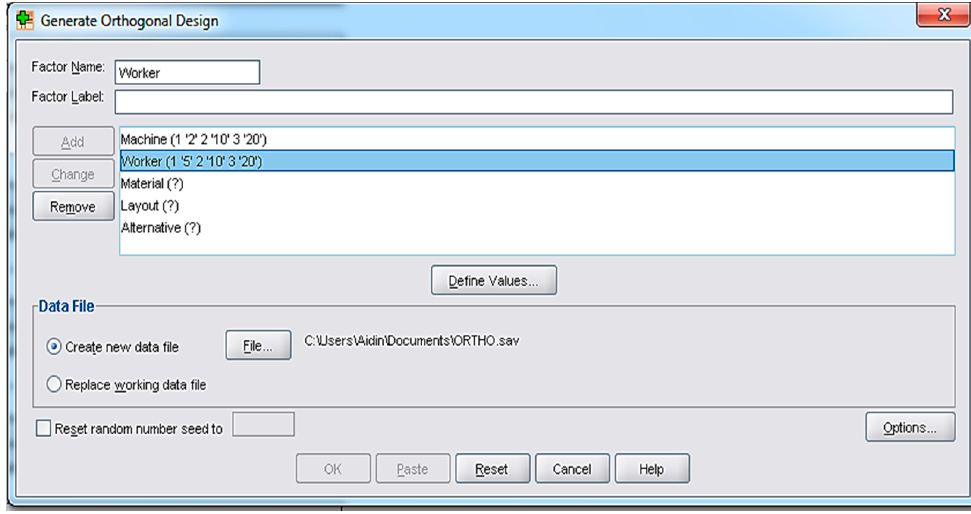
Figure 19. Defining factors in orthogonal design.